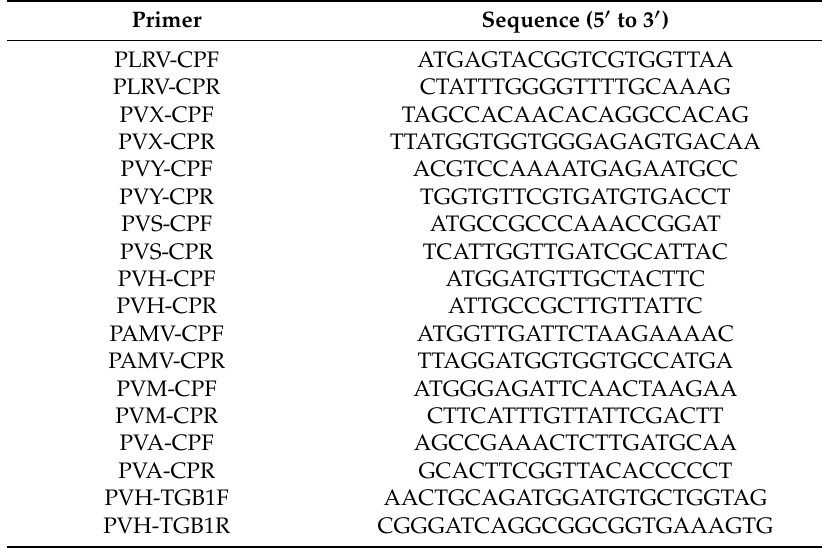
Table 3. Primers used for RT-PCR detection in this